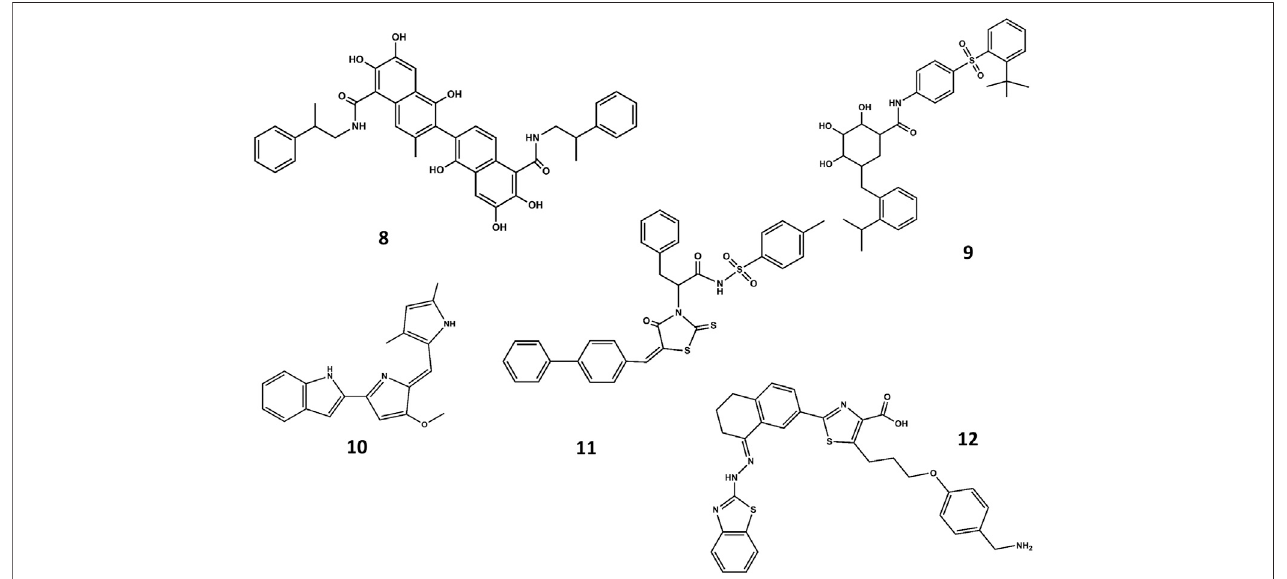
FIGURE 7 | Chemical structures of diverse small molecule mimics of the BH3 domain. Sabutoclax ( 8 ); TW-37 ( 9 ); obatoclax ( 10 ); WL-276 ( 11 ); WEHI-539 ( 12 ).